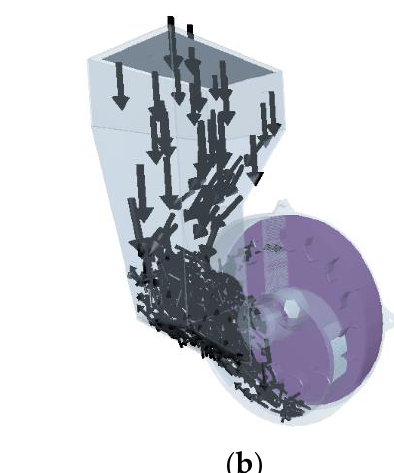
Figure 11. The stir seed simulation process of a sucking-seed plate with different teeth. ( a ) The number of teeth is 9; ( b ) The number of teeth is 15.